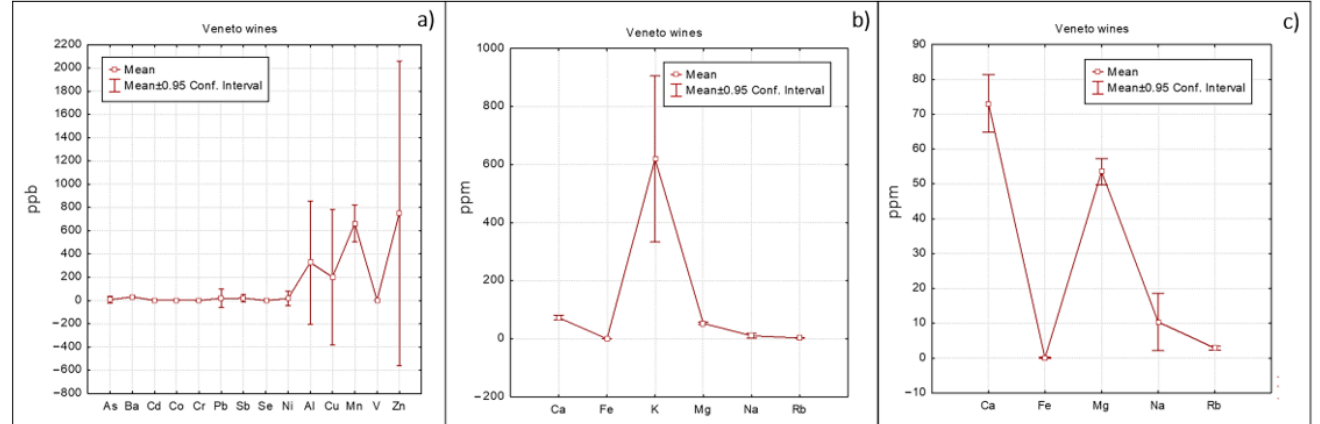
Figure 2. Elements trend concentration for Veneto wines: ( a ) minor elements, ( b ) major elements and ( c ) major elements excluding K.